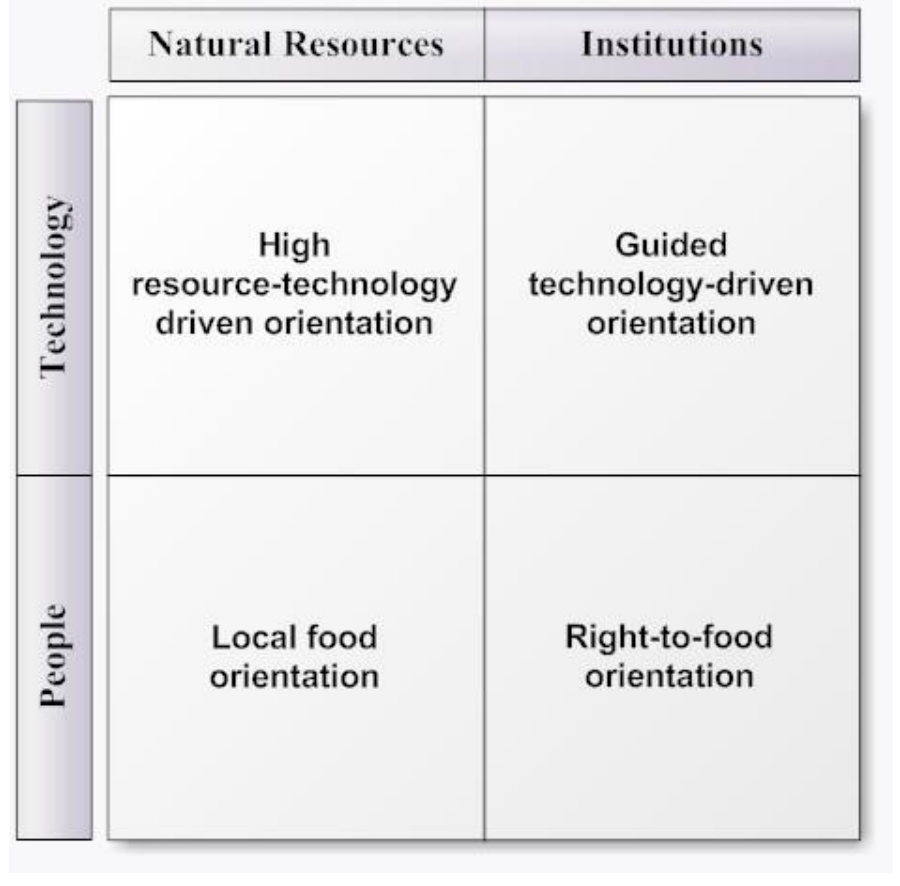
Figure 1. The Agricultural Growth Orientation